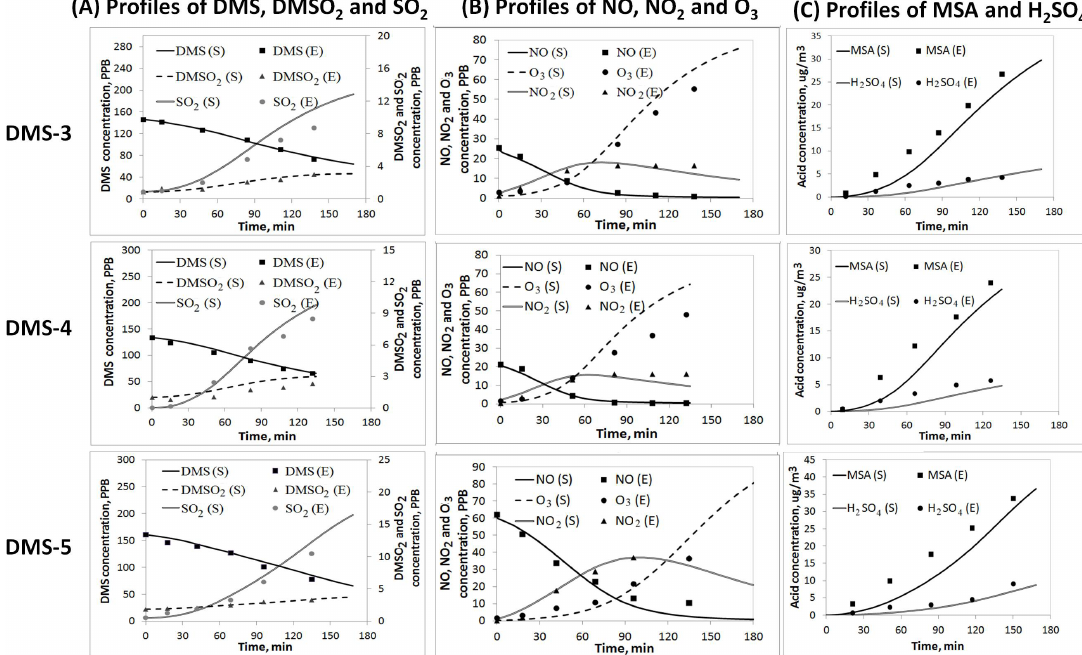
Fig. 3. Time profiles of DMS, DMSO 2 , SO 2 , MSA, H 2 SO 4 , NO x and O 3 for the photooxidation of DMSO in the presence of NO x (Exp DMS-3, Exp DMS-4 and Exp DMS-5 in Table 1). “E” denotes the experimentally observed concentrations of chemical species and “S” for those simulated using the kinetic